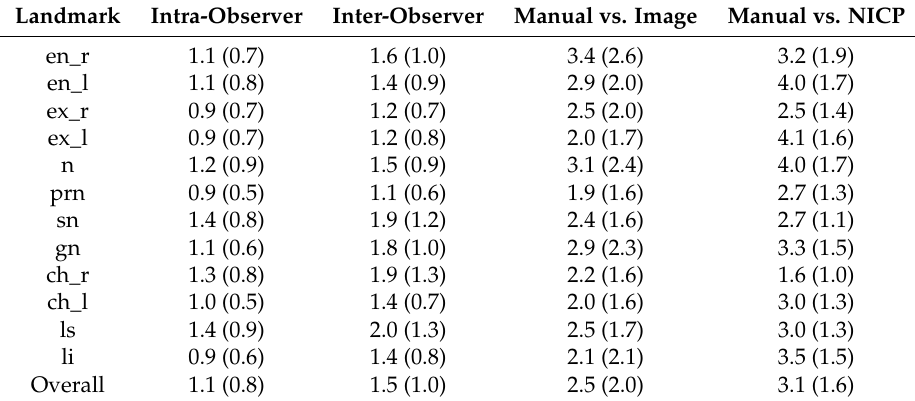
Figure 6. A boxplot comparing the Euclidean distances between landmark positions identified using different landmarking procedures. The boxes extend from the Q1 to Q3 quartile values of the data, with a line at the median. The position of the whiskers is set to 1.5 times the interquartile range (Q3–Q1) from the edges of the box. Table 1. The mean and standard deviation of the Euclidean distances between different sets of landmarks. All values have units of